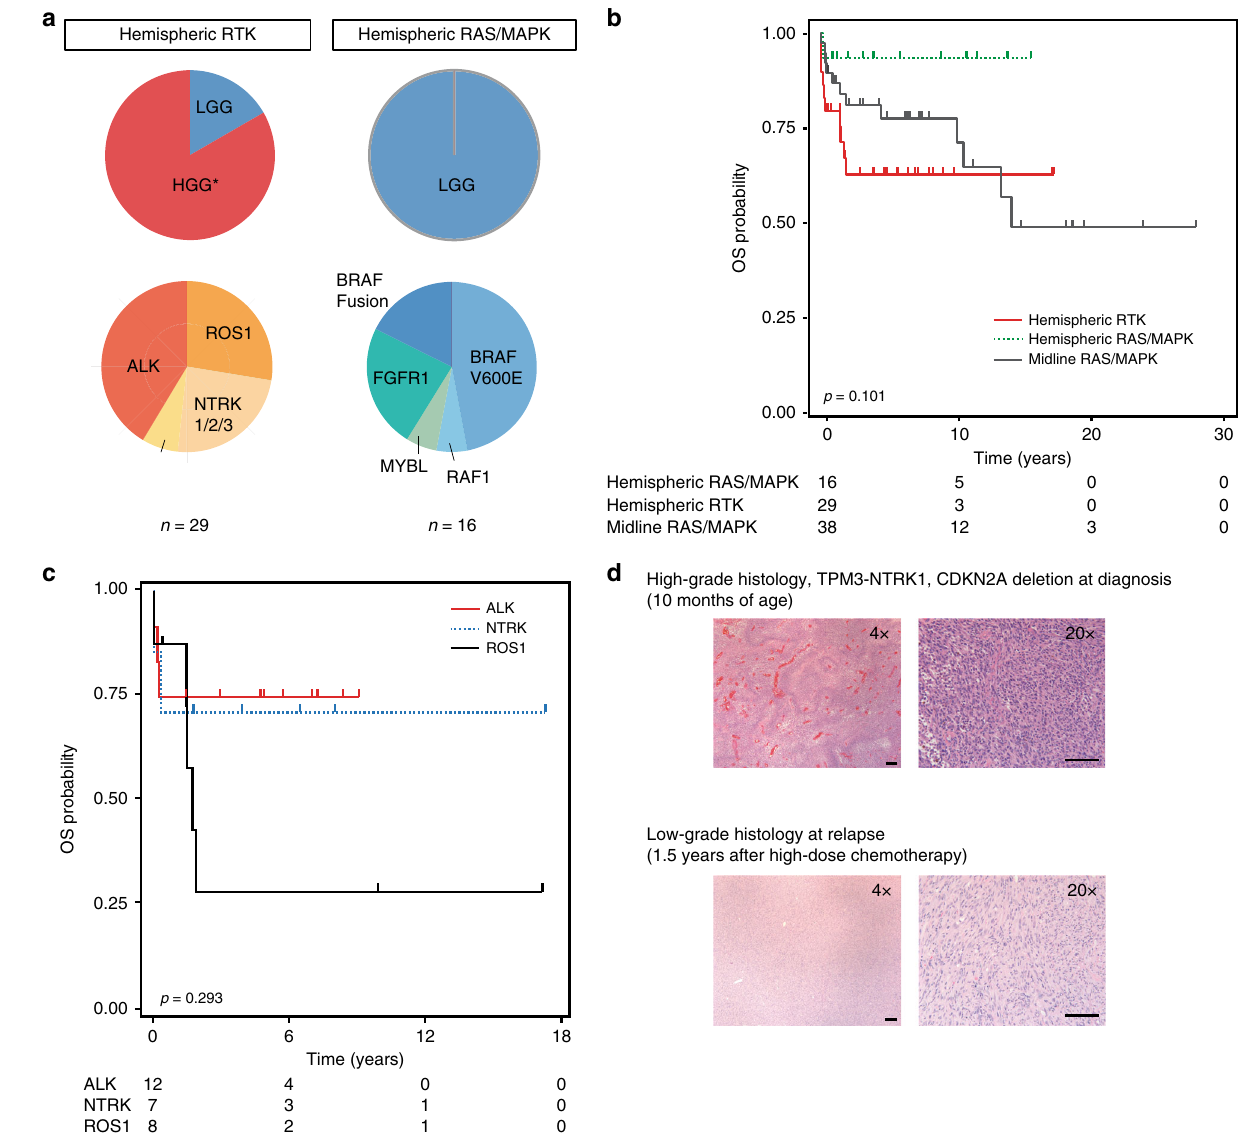
Fig. 4 Characteristics of hemispheric glioma in infants. a Histological grade and molecular alterations in Group 1 Hemispheric RTK and Group 2 Hemispheric RAS/MAPK infant gliomas. b Overall survival (OS) of infants according to glioma subgroups, p value calculated using the log-rank test. c Survival of infants with hemispheric gliomas with respect to patient ALK , ROS1, and NTRK status, p value calculated using the log-rank test. d Hematoxylin and eosin (H&E) staining of an infant high grade glioma at diagnosis and second surgery post-chemotherapy, showing a maturing phenotype characterized by lower grade histology. Images are taken at the stated magni fi cation, scale bar = 100 μ m for x20, 200 μ m for ×4. HGG: high-grade glioma, LGG: